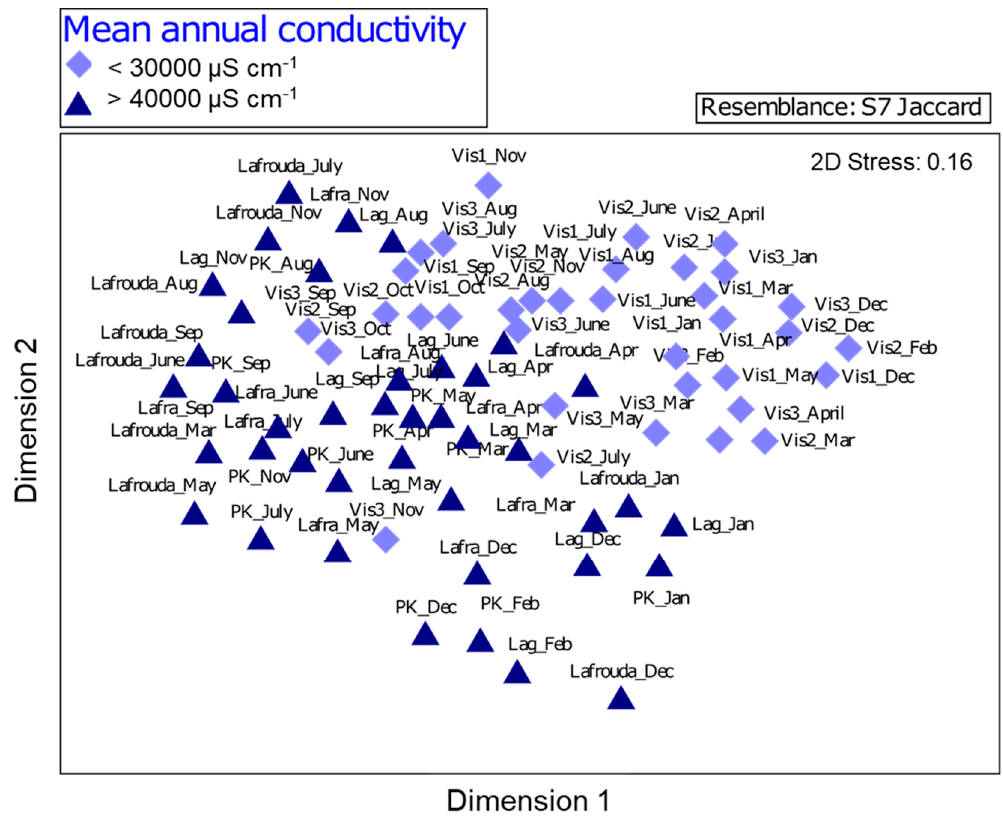
Figure 4. Multidimensional scaling plot of phytoplankton biomass variation in Lafra, Lafrouda, Lagos (Lag), Palaia Koiti (PK) and Vistonis (Vis1, Vis2, Vis3) lagoons according to Jaccard similarity index. Samples with mean annual conductivity lower than 30,000 µ S cm − 1 are represented with a light blue rhomb and samples with mean annual conductivity higher than 40,000 µ S cm − 1 are represented with a dark blue triangle. 2D Stress value: 0.16.